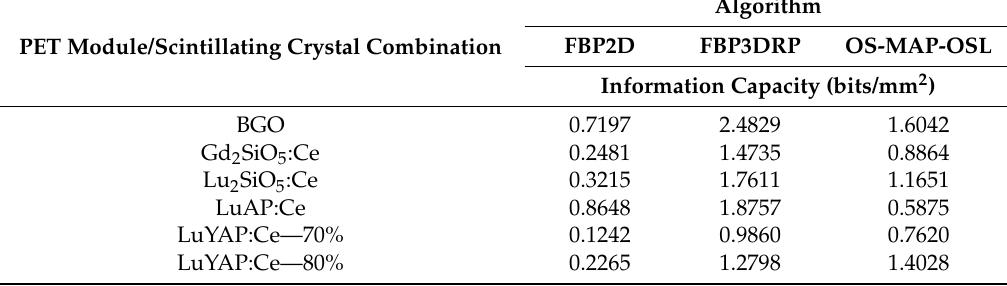
Table 2. Information capacity values for different crystal